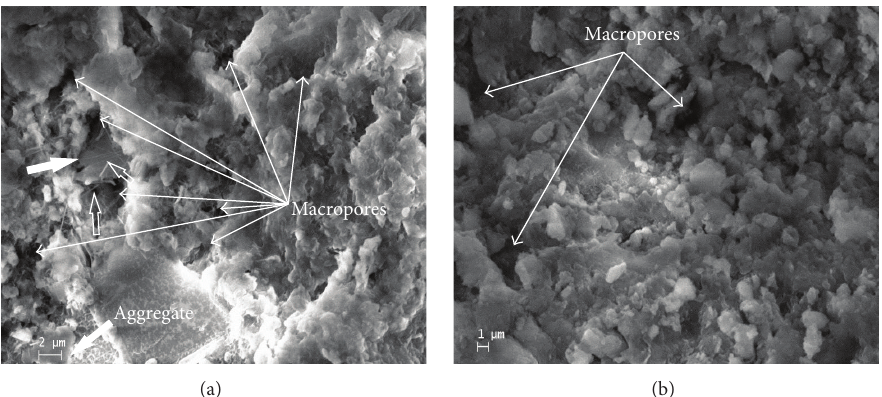
Figure 12: ESEM images of concrete with w / b = 0.65 : (a) control and (b) with 1.5% NS addition. CH plates (solid arrows) and ettringite needles (hollow arrows) are also visible in (a).